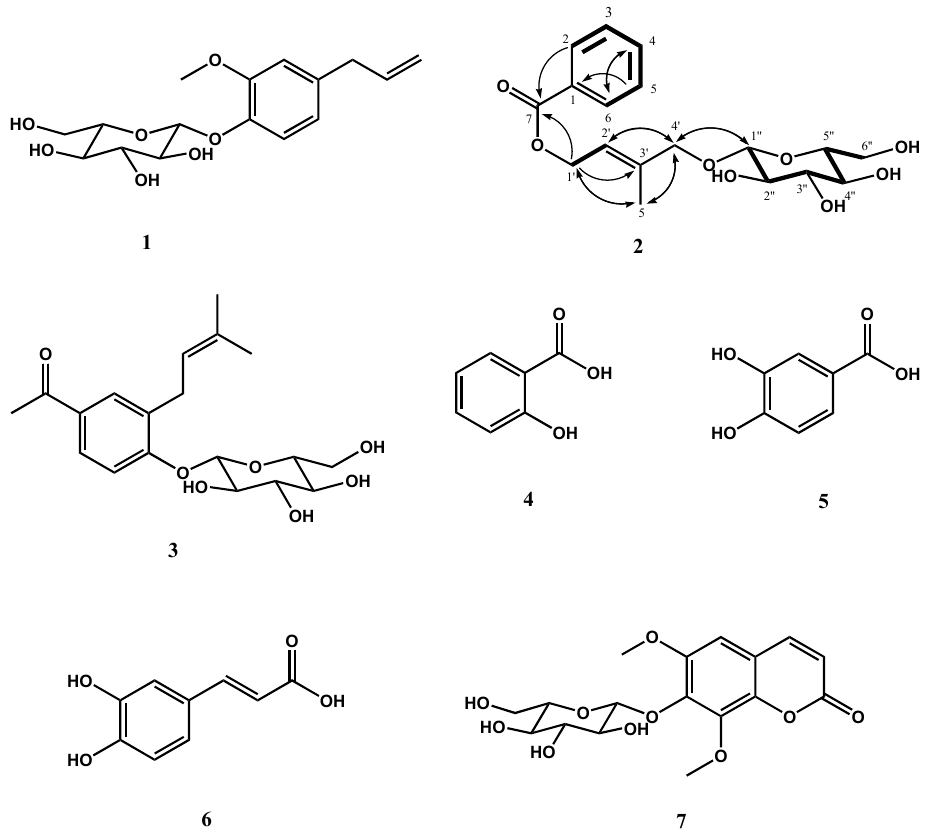
Figure 5. Structures of ACE inhibitors from AS and the important 1 H- 1 H COSY (bold lines) and HMBC (arrows) correlations for 2 .